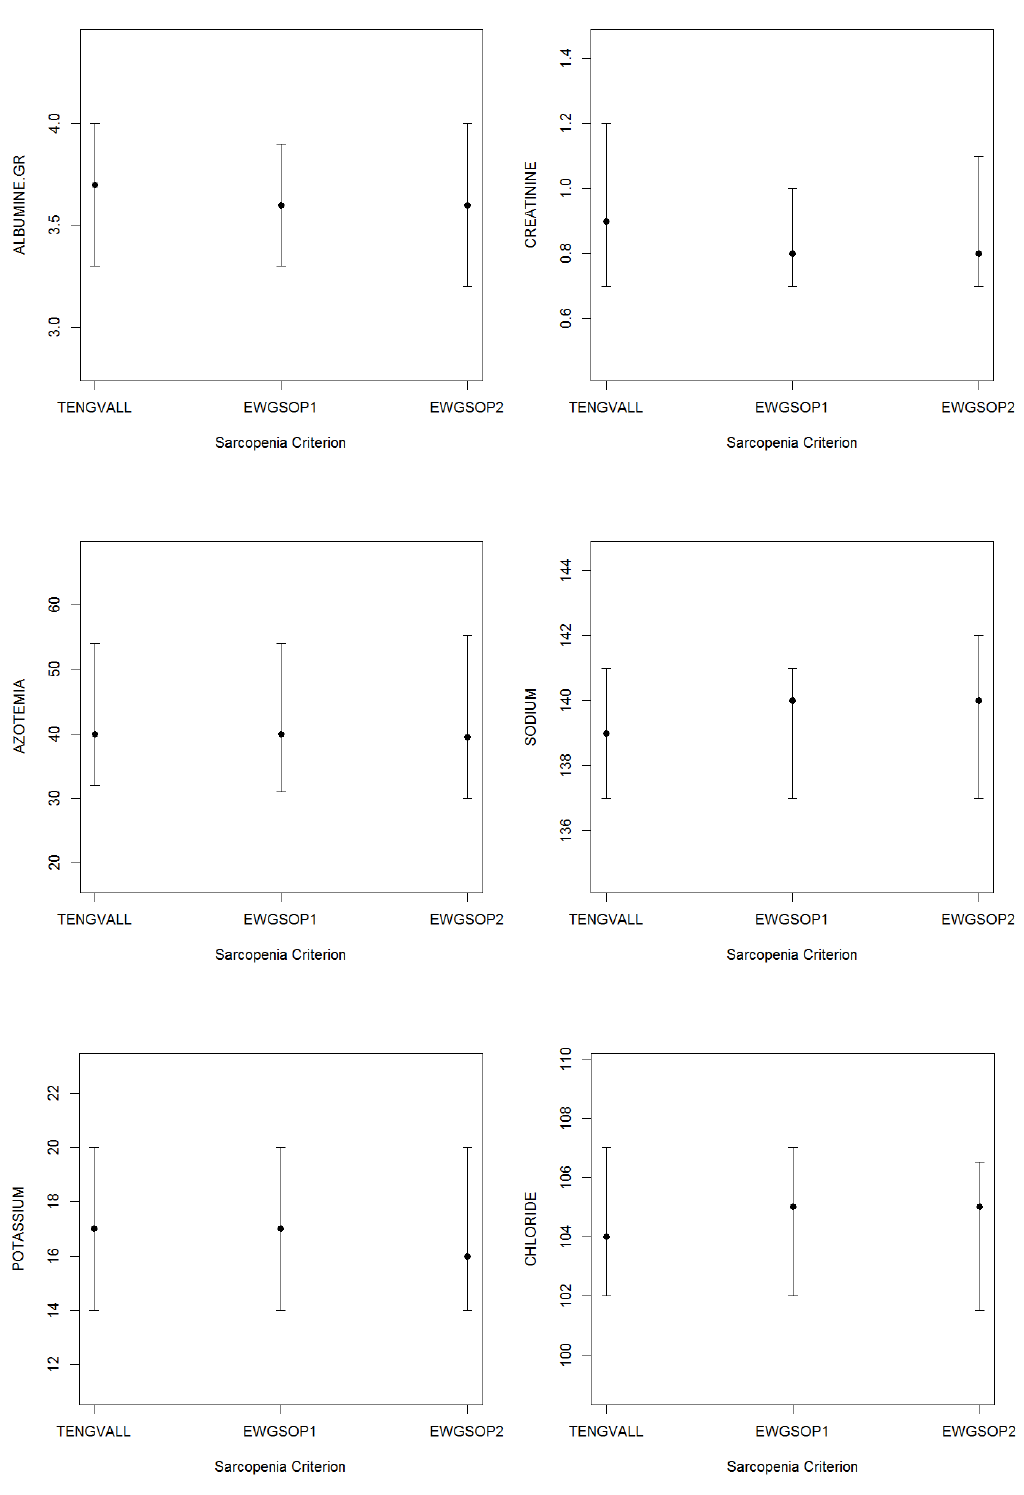
Figure A4. Summary of patients with low ASMI characteristics under each diagnostic criterion. The points represent medians, while lower and upper quartiles are represented by the vertical bars.